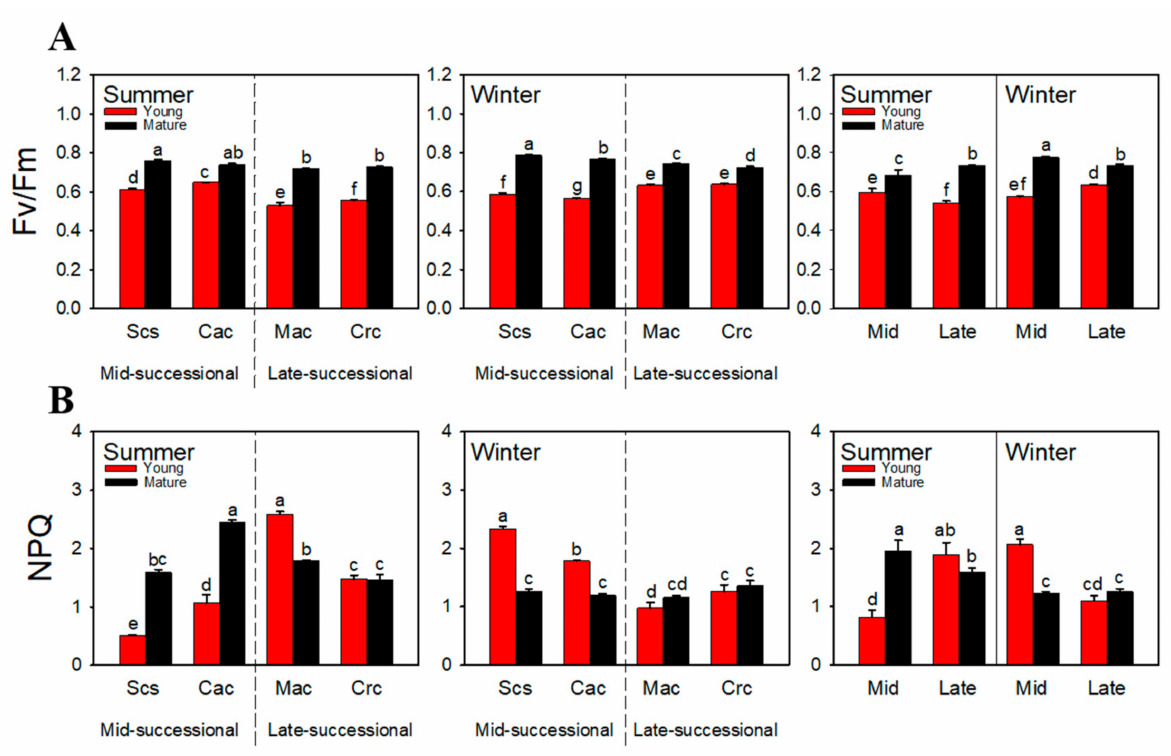
Figure 2. Fv/Fm ( A ) and NPQ ( B ) of dominant species at different successional stages in different seasons. Scs, Schima superba ; Cac, Castanopsis chinensis ; Mac, Machilus chinensis ; Crc, Cryptocarya chinensis ; Mid, mid-successional tree group; Late, late-successional species tree group. Different letters above bars indicate statistical significance ( p <